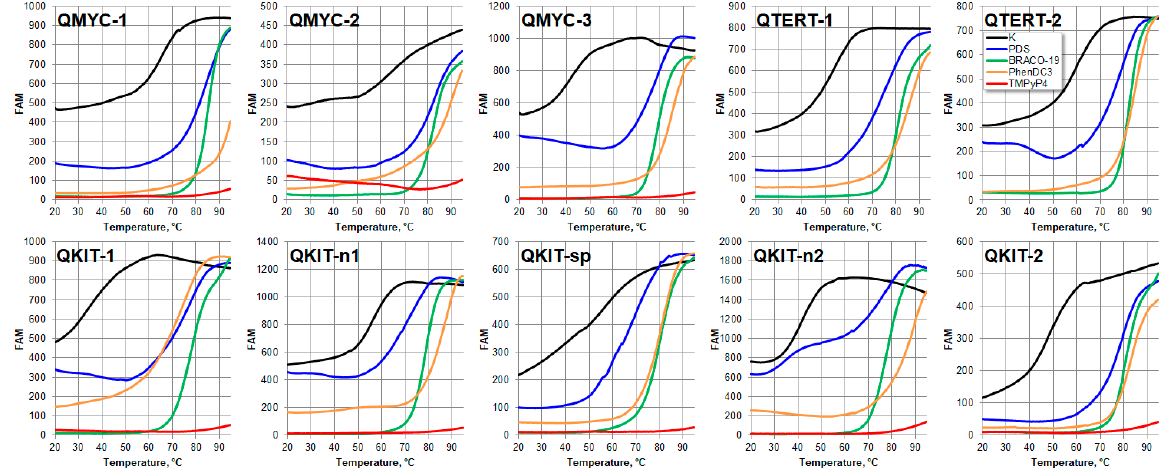
Figure 4. FRET melting profiles for DNA oligonucleotides corresponded with the polymerase pause sites in the presence of potassium ions or G4 ligands (10 mM KCl (black), 0.5 µM PDS (blue), 2.5 µM BRACO-19 (green), 0.5 µM PhenDC3 (orange) and 1 µM TMPyP4 (red)). Table 1. Stability of folded DNA structures obtained by FRET melting assay in presence of potassium or G4